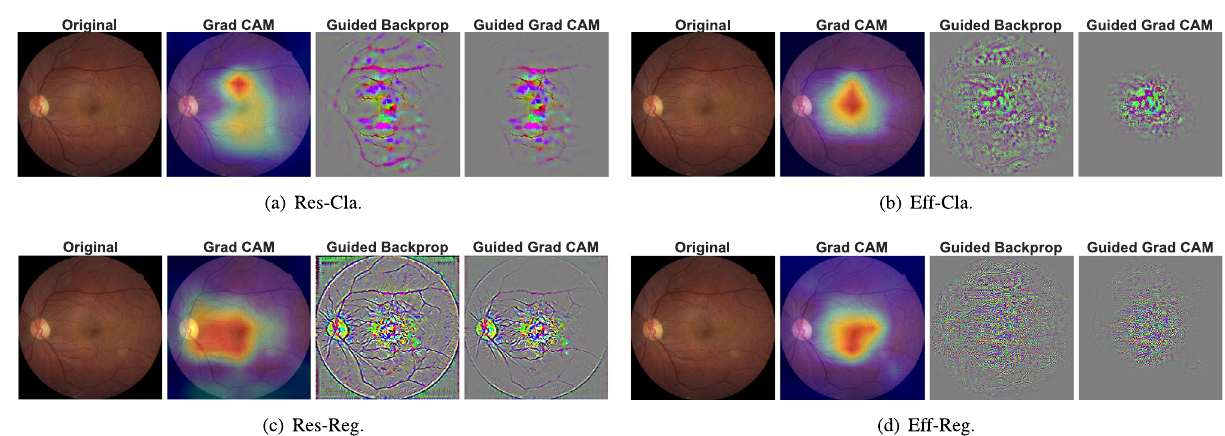
Figure 3. Class activation visualization of the considered schemes with fundus image. For each sub-figure, the first, second, third, and fourth image correspond to the original fundus image, Grad CAM results, Guided Back- propagation result, and Guided Grad CAM results, which combine Grad CAM and Guided Back-propagation,